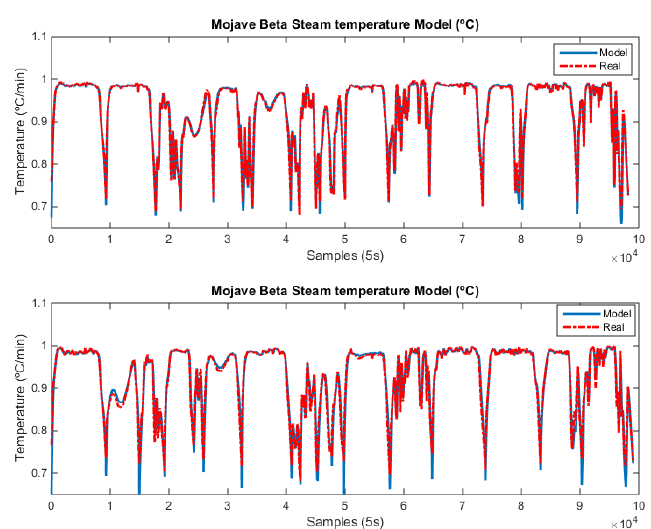
Figure 14. Mojave Beta and Alpha: Steam temperature model: ( top ) Mojave Beta model showing real evolution (red dash-dotted) and model output (blue solid); and ( bottom ) Mojave Alpha model showing real evolution (red dash-dotted) and model output (blue solid).